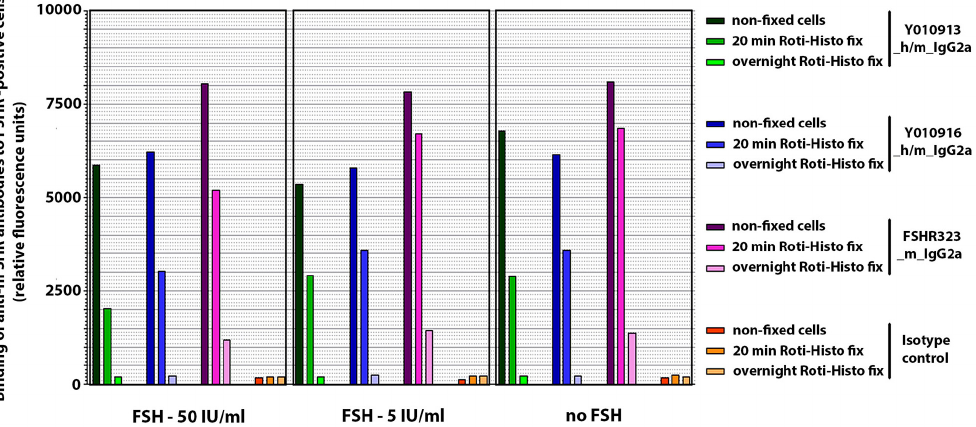
Figure 5. Effect of FSH on binding of FSHR323, Y010913, and Y010916 to fixed cells expressing FSHR. FSH was added in excess to the FSHR expressing cells, followed by fixation with PBS-buffered paraformaldehyde for 20 min or overnight. Non-fixed cells were used as a positive control. A non-related mouse IgG2a antibody served as negative control.